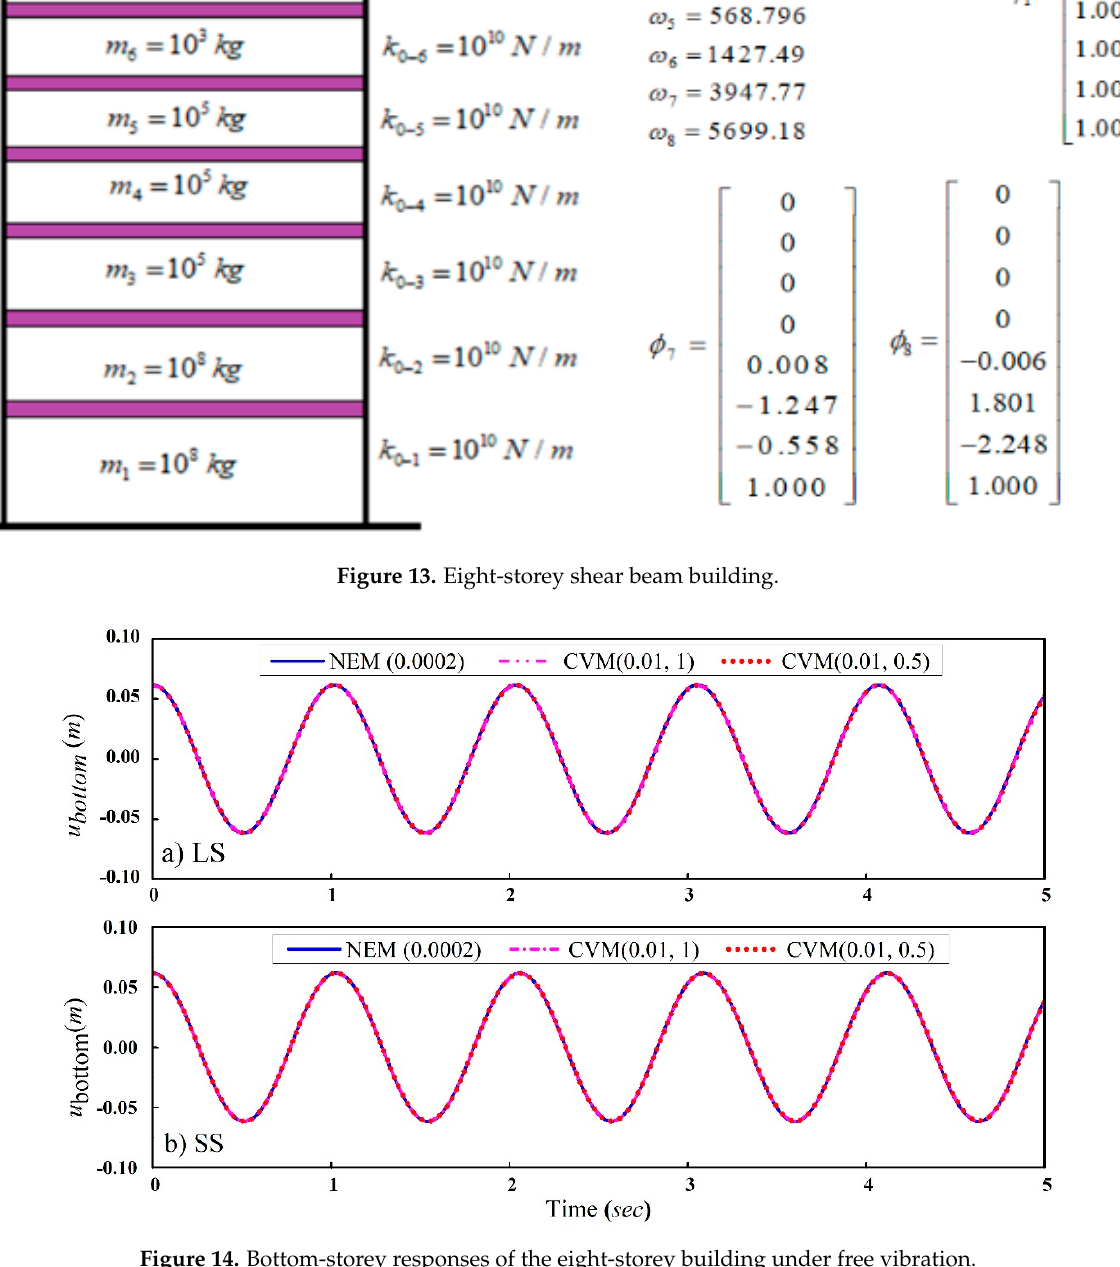
Figure 14. Bottom-storey responses of the eight-storey building under free vibration.